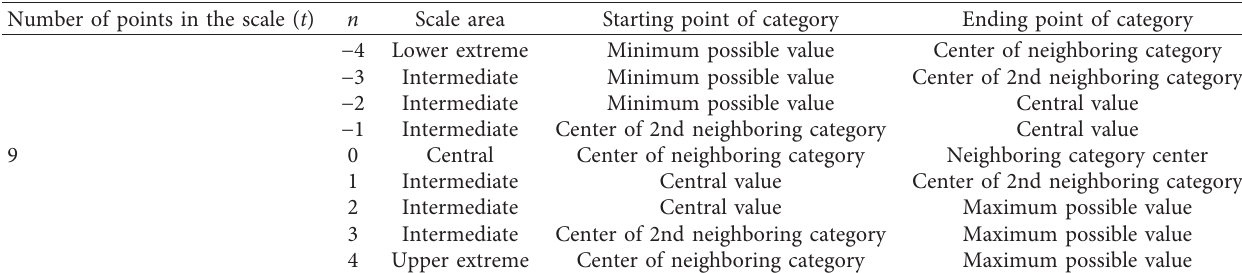
Table 2: Determination of the starting and ending points of each category based on a 9-point fuzzy nonbalanced scale. Number of points in the scale ( t )